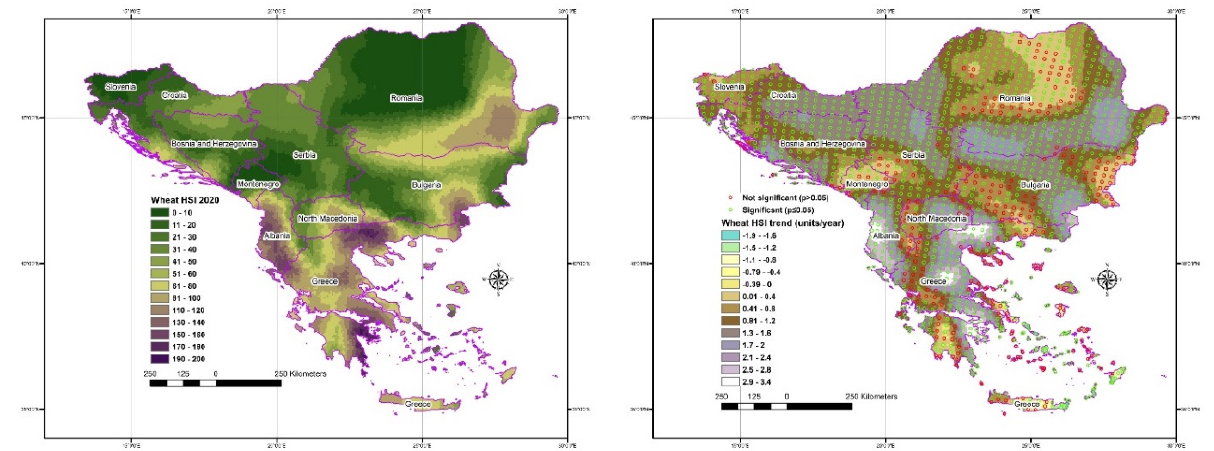
Figure 10. The HSI distribution for the wheat cultivation in 2020 ( left ) and the HSI trend with statistical significance marks ( right ).